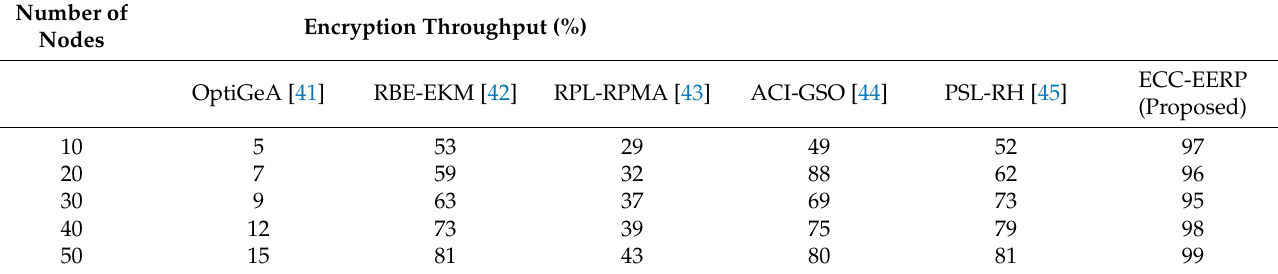
Figure 5. Encryption throughput of the proposed and existing methods [41–45]. Table 4. Encryption throughput of the proposed and existing methods .